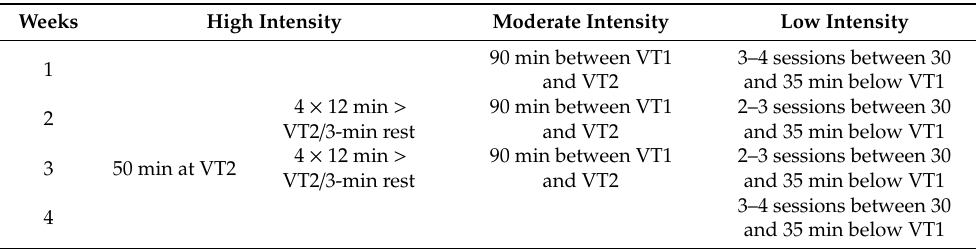
Table 1. Periodization and training distribution for the heart rate variability group (HRV-G) and traditional-based training group (TRAD-G) during the preparation period (PR).